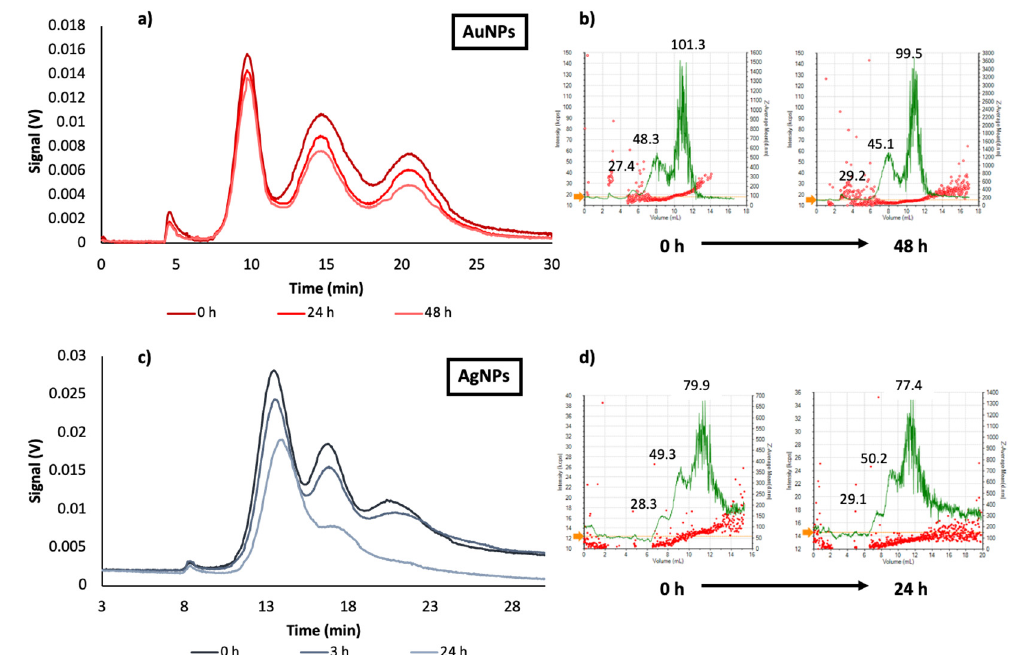
Figure 5. Mixtures of different sizes of AuNPs (dilution 1/8) and AgNPs (dilution 1/4). ( a ) Fractograms of the evolution of 20, 40 and 80 nm AuNPs mixture; ( b ) DLS values of AuNPs sizes, DLS fractograms in green and hydrodynamic diameters distribution in red; ( c ) fractograms of the evolution of 20, 40 and 60 nm AgNPs evolution mixture; ( d ) DLS values of AgNPs sizes, DLS fractograms in green and hydrodynamic diameters distribution in red. Nanomaterials 2020 , 10 , x FOR PEER REVIEW